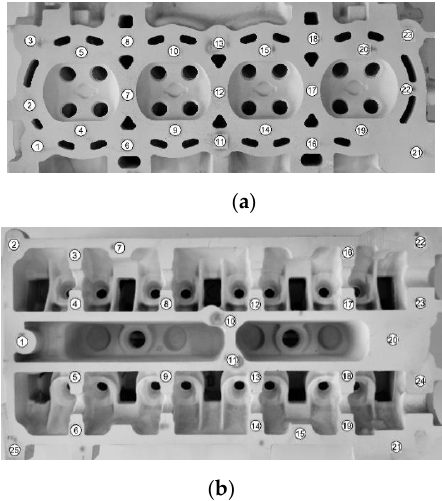
Figure 4. Positions of hardness measurement on milled surfaces of the cylinder head casting: ( a ) from the combustion chamber side, ( b ) from the camshafts’ side.